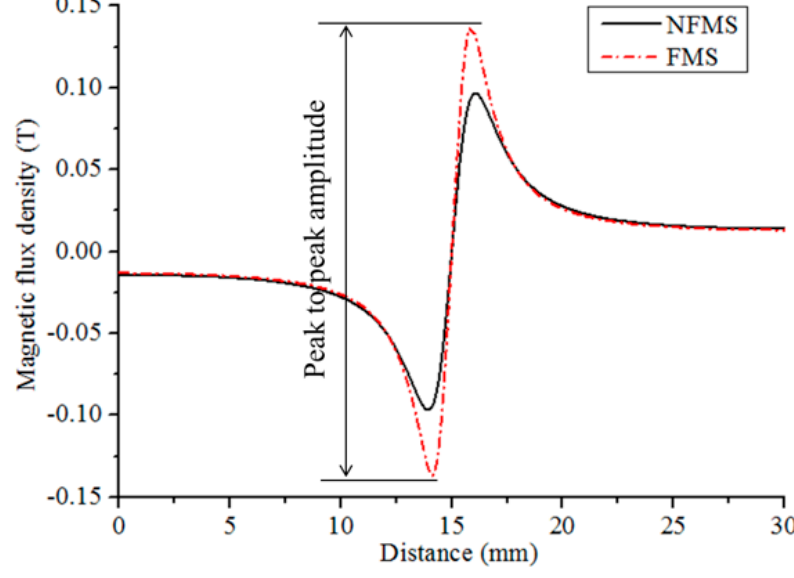
Figure 6. The MFL signals influenced by different supports.